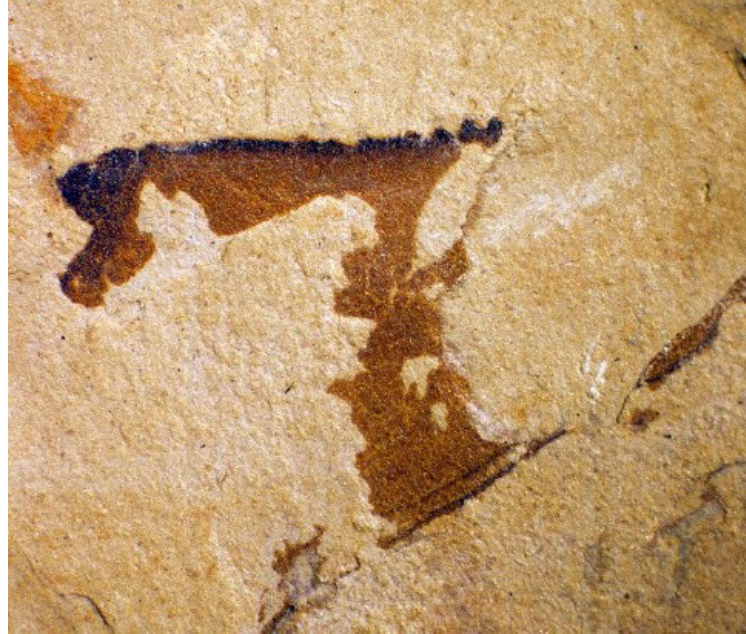
Figure 16. Shenzianyuloma yunnanense nov. gen. nov. sp. IGM 5008. Dorsal fin detail showing